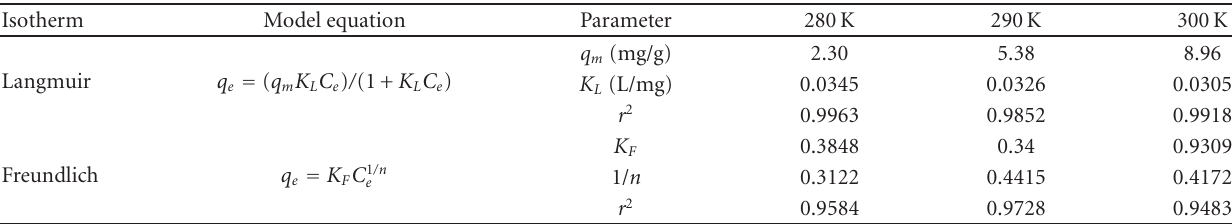
Table 3: Parameters determined from Langmuir and Freundlich isotherms of CNT-CNF film electrodes in CuCl 2 solution ( q e is the amount of adsorbed CuCl 2 per unit mass of CNT-CNF film; q m is the maximum removal capacity corresponding to complete monolayer coverage; K L and K F are Langmuir constant and Freundlich constant; r 2 is correlation coe ffi cients).